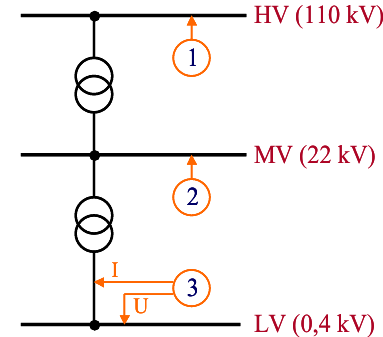
Fig. 2. Ideal connection diagram of measuring points